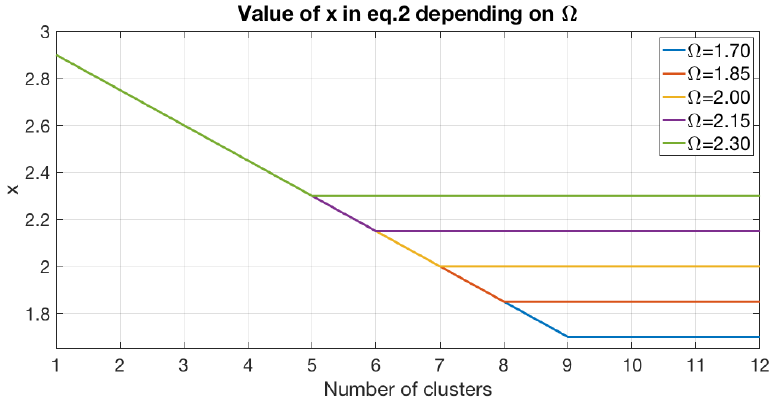
Figure 5. Values of x in the node level loop closure condition versus number of clusters in Equation